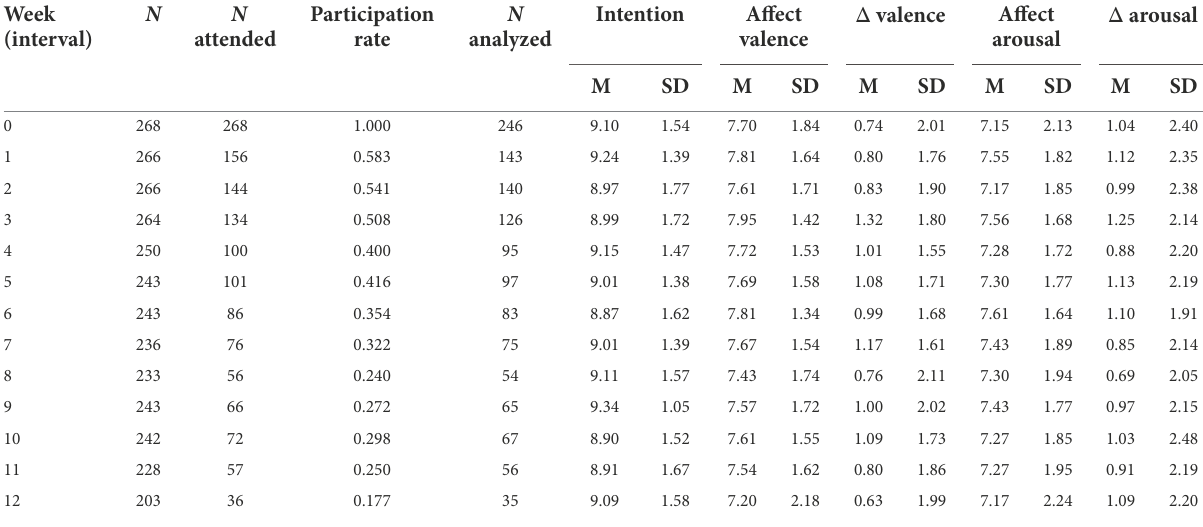
TABLE 1 Participation in exercise classes and changes in psychological variables over time. Week